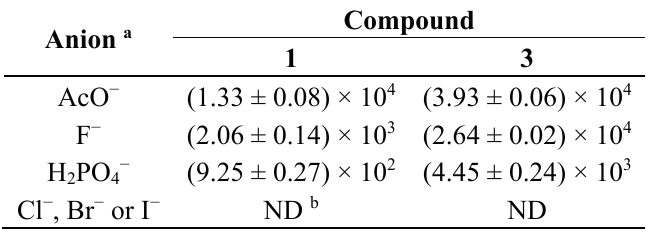
Table 1. The binding constants K s (M − 1 ) of the compounds with various